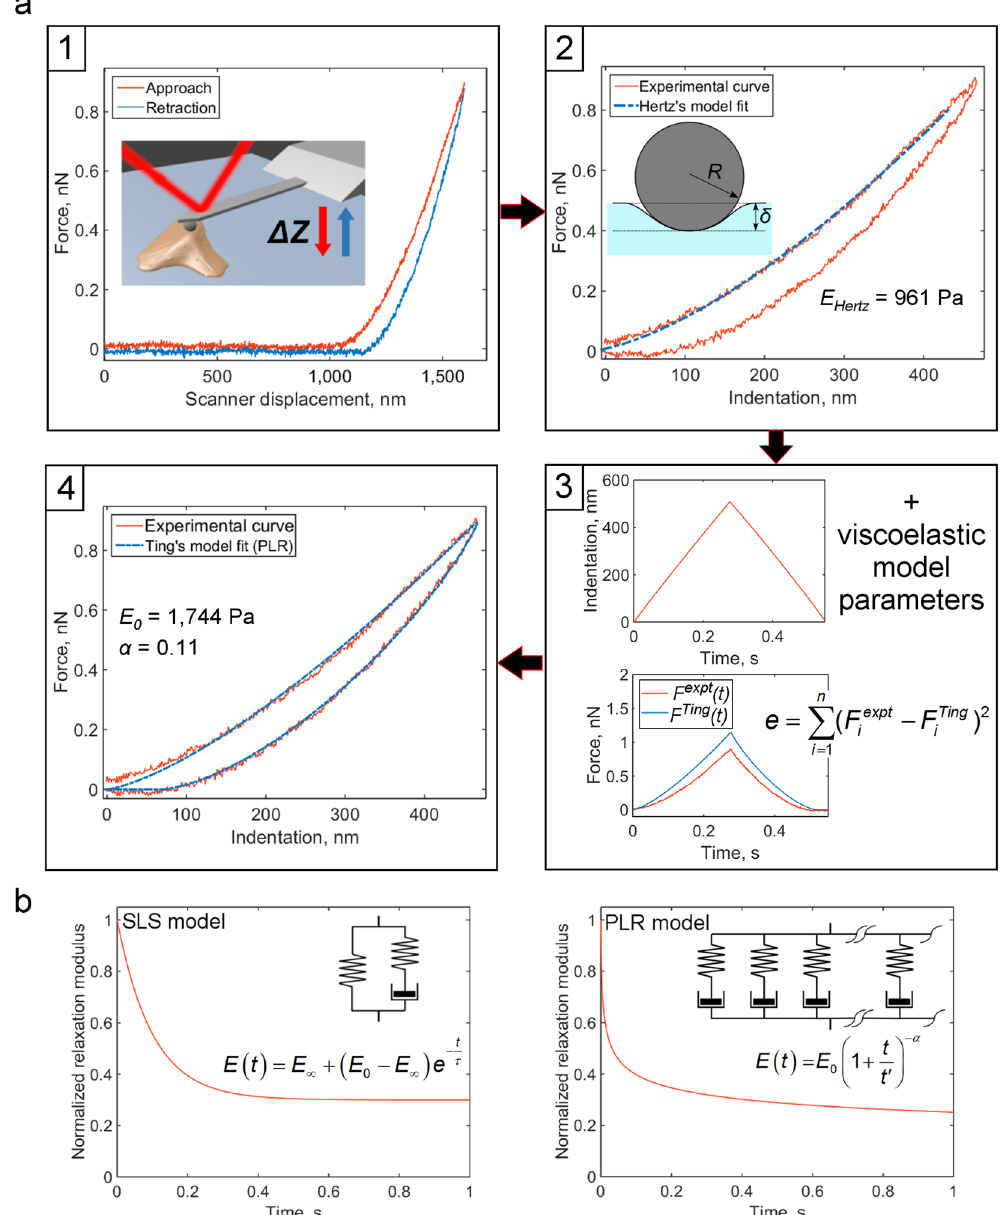
Figure 1. Flowchart of the method and used viscoelastic models. ( a ) The flowchart. At the first step, a force- displacement curve obtained with a standard indentation protocol is pre-processed to determine zero force level and corrected for hydrodynamic drag (if needed). At the second step, the contact point is located and F - Z curve is transformed to the force-indentation coordinates. Apparent Young’s modulus E Hertz is calculated with the Hertz’s model. Inset: scheme of a spherical probe indenting a half-space. At the third step, the indentation time history is used to model the force curve with the Ting’s model and prescribed viscoelastic model. The difference between the modelled and experimental force curves ( e ) is minimized with the fitting algorithm. Viscoelastic parameters providing the lowest e value are acquired as the output. At the final step, contact point position could be adjusted and the step 3 repeated to obtain the best fit. Details of the processing are given in the text. ( b ) Normalized relaxation modulus ( E / E 0 ) for standard linear solid (SLS) and power-law rheology (PLR) relaxation models. Insets: schematic spring-dashpot representation and equation for the relaxation modulus. The SLS model is a spring in parallel with a spring-dashpot combination, leading to an exponential relaxation with a single relaxation time τ . The PLR model can be imagined as an infinite number of spring-dashpot combinations in parallel, leading to a continuous relaxation spectrum and power-law decay ( α is the power law